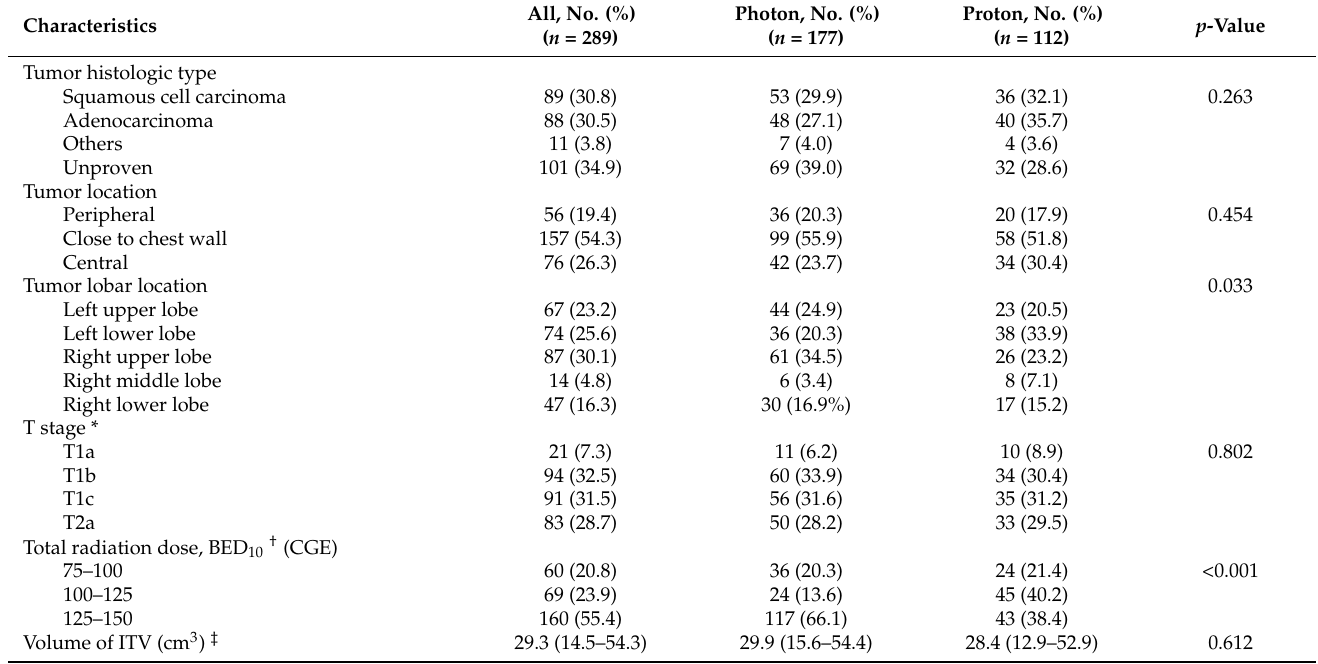
Table 2. Tumor and treatment